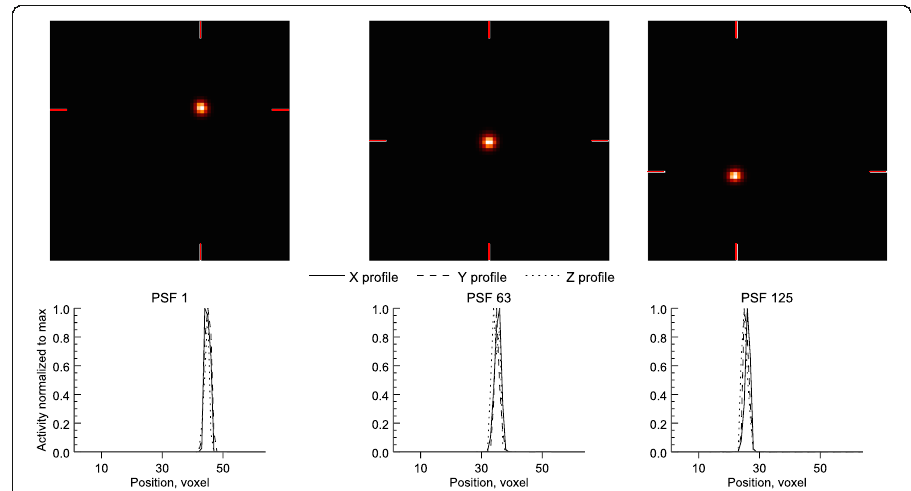
Fig. 2 Maximum intensity projections of reconstructed point sources, in the x - y -plane, for the first, middle, and final source positions in the measurement grid. Line profiles are shown for the x - (solid), y -(dashed), and z - (dotted) directions with the positions of the former two marked by the red indicators. Each profile was normalized to have a maximum value of 1. The reconstructed point sources are symmetric in all directions, and no major artefacts are visible